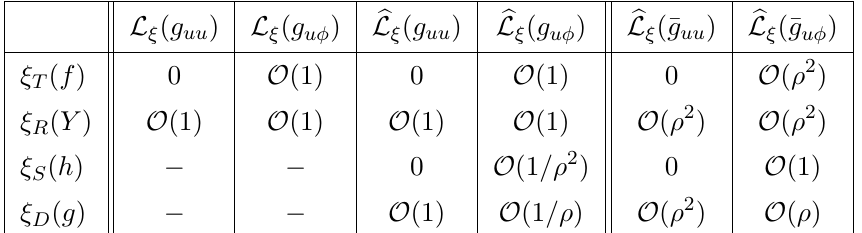
Table 3 . Non vanishing ordinary and conformal Lie derivatives of the metric g µν and ¯ g µν = g µν /w 2 ( x µ ) when considering the vectors in (2.12) for arbitrary functions f ( φ ) , Y ( φ ) , h ( φ ) and g ( φ ) . Since the vectors ξ T ( f ) and ξ R ( Y ) have vanishing divergence we can replace the ordinary Lie derivatives in the first two columns by the conformal